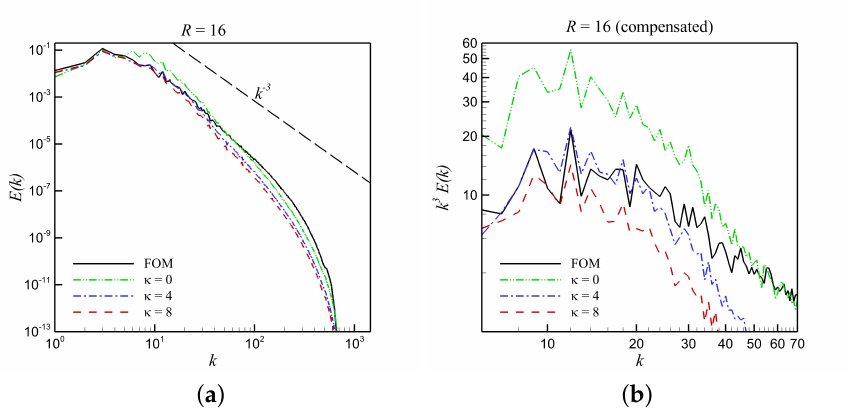
Figure 11. Energy spectra at final time predicted by ROMs in the presence of stabilization, compared to the FOM spectrum and k − 3 scaling ( a ), with a compensated view in ( b